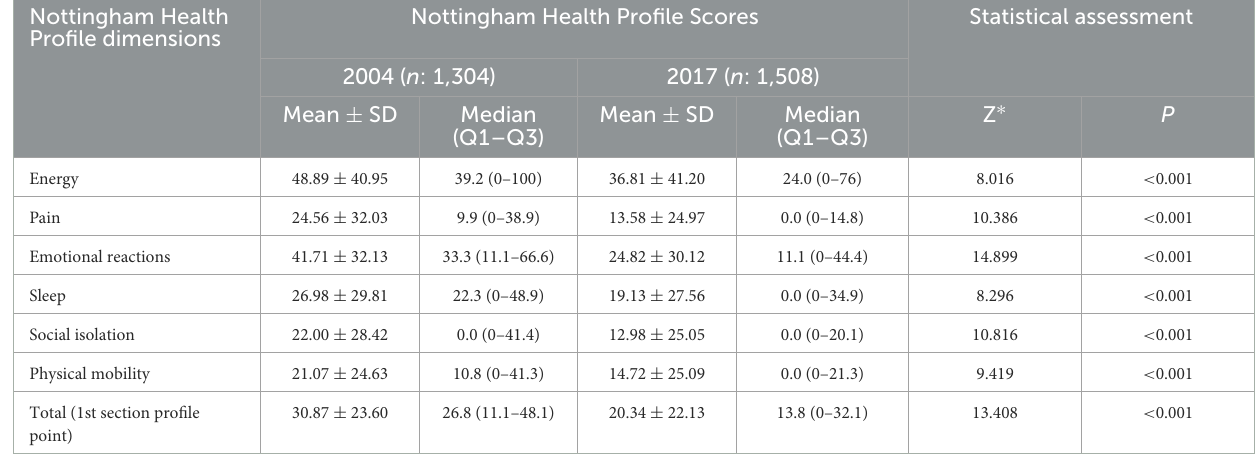
TABLE 3 Nottingham Health Profile Scores of respondents aged 15 and over in 2004 and 2017. Nottingham Health Profile